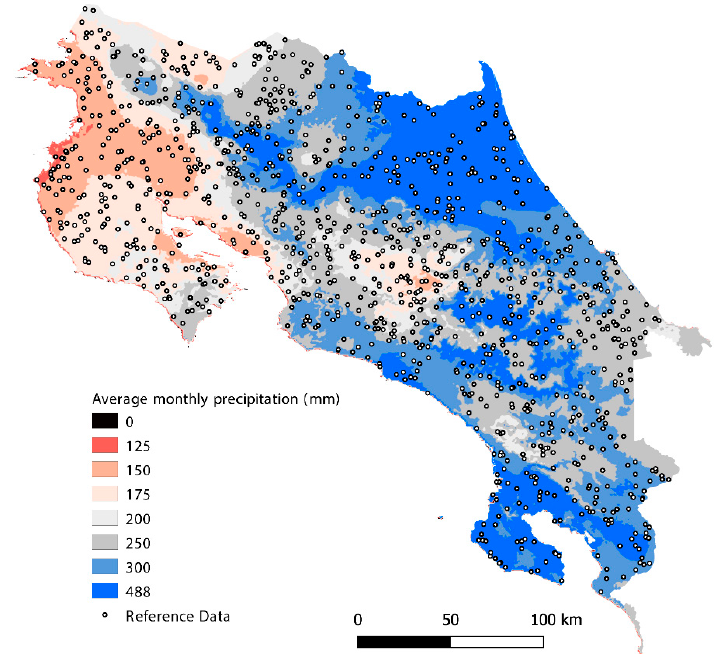
Figure A2. Precipitation across Costa Rica, with locations of reference data shown. Note differences in rainfall between the east and west of the country.